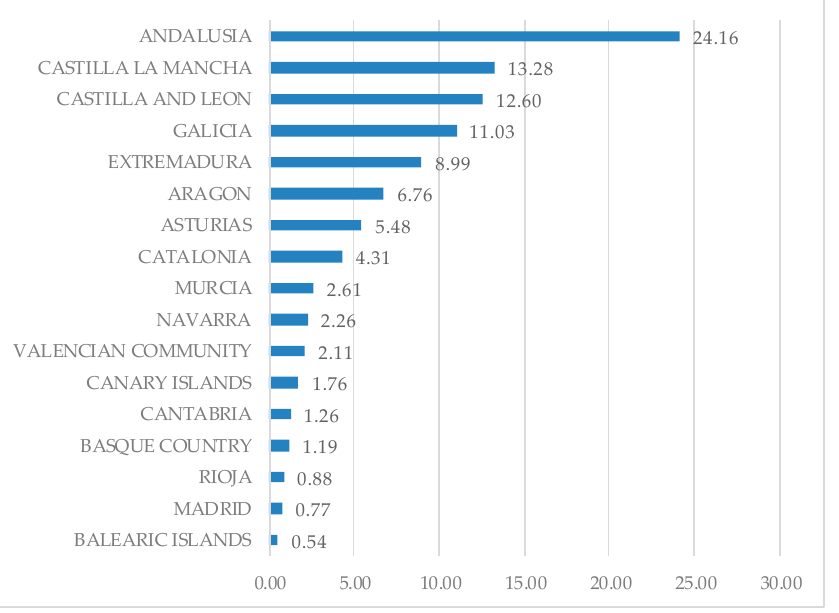
Figure 3. Percentage distribution of the EAFRD for the period 2014–2020 (Source: Own elaboration from data published by the Ministry of Agriculture, Fisheries and Food). Figure 2 shows how almost 70% of these funds are concentrated in five regions: An- dalusia, Castilla La Mancha, Castilla and Leon, Galicia, and Extremadura. In all of them, the agricultural sector plays an important role in generating its regional GDP. Figure 3 shows the percentage distribution for the period 2014–2020. On this occa- sion, the five regions above continue to occupy the top positions, with the highest amount of funds received, but to a lesser extent. In fact, among them, they receive 64% of the total from the said funds. It should also be noted how the regions of Aragon, Cantabria, and